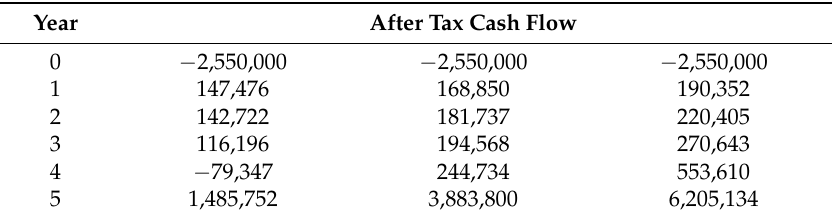
Table 15. Fuzzy amounts of After Tax Cash